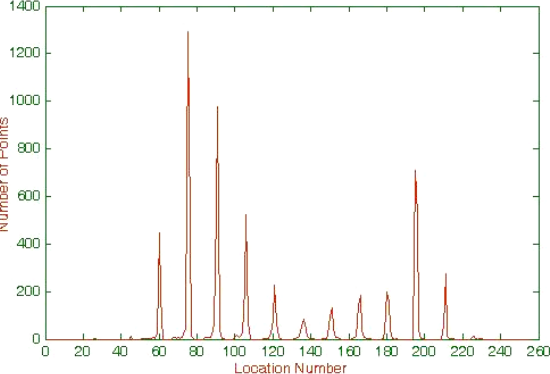
( s ) vs log ( N ( s )) plot for the SSM of face Fig. 4. The log 10 10 image of the person in AT & T face